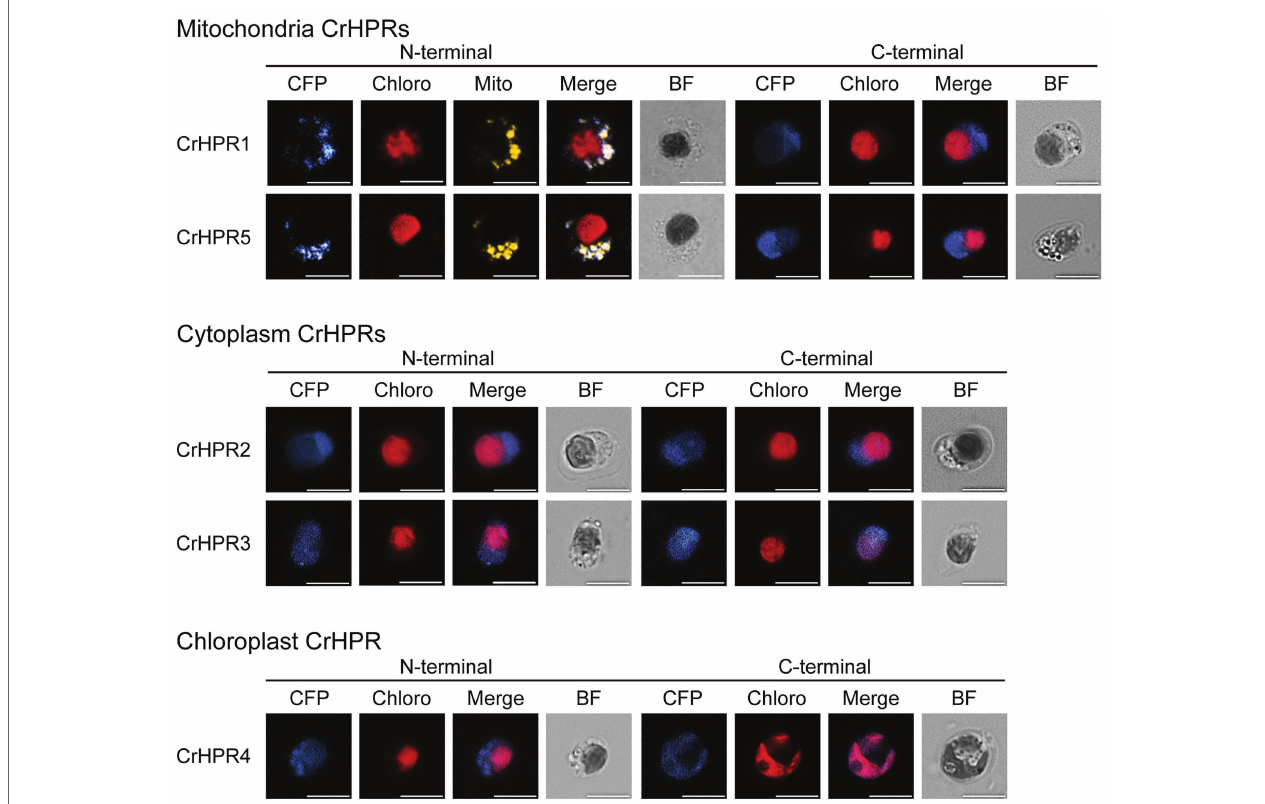
FIGURE 1 | Subcellular localization of the mCerulean fluorescent protein (CFP) reporter fused with N- or C-terminal peptides from CrHPRs. Location signal at the N-terminal or C-terminal of each CrHPR is attached to the CFP reporter protein as described in the methods. Each set of images shows intact cell from the WT/ CC-125 or transformants, and representative results are shown here. Mitochondria, probed with red. Mitotracker dye is shown in yellow color here to differentiate from the red autofluorescence of chloroplast. Individual imaging channels are presented. CFP, mCerulean fluorescent protein; Chloro, chlorophyll autofluorescence; Mito, MitoTracker probe; Merge, overlayed channel of CFP, Mito, and Chloro; and BF, bright field image. Scale bar, 5 μ m.